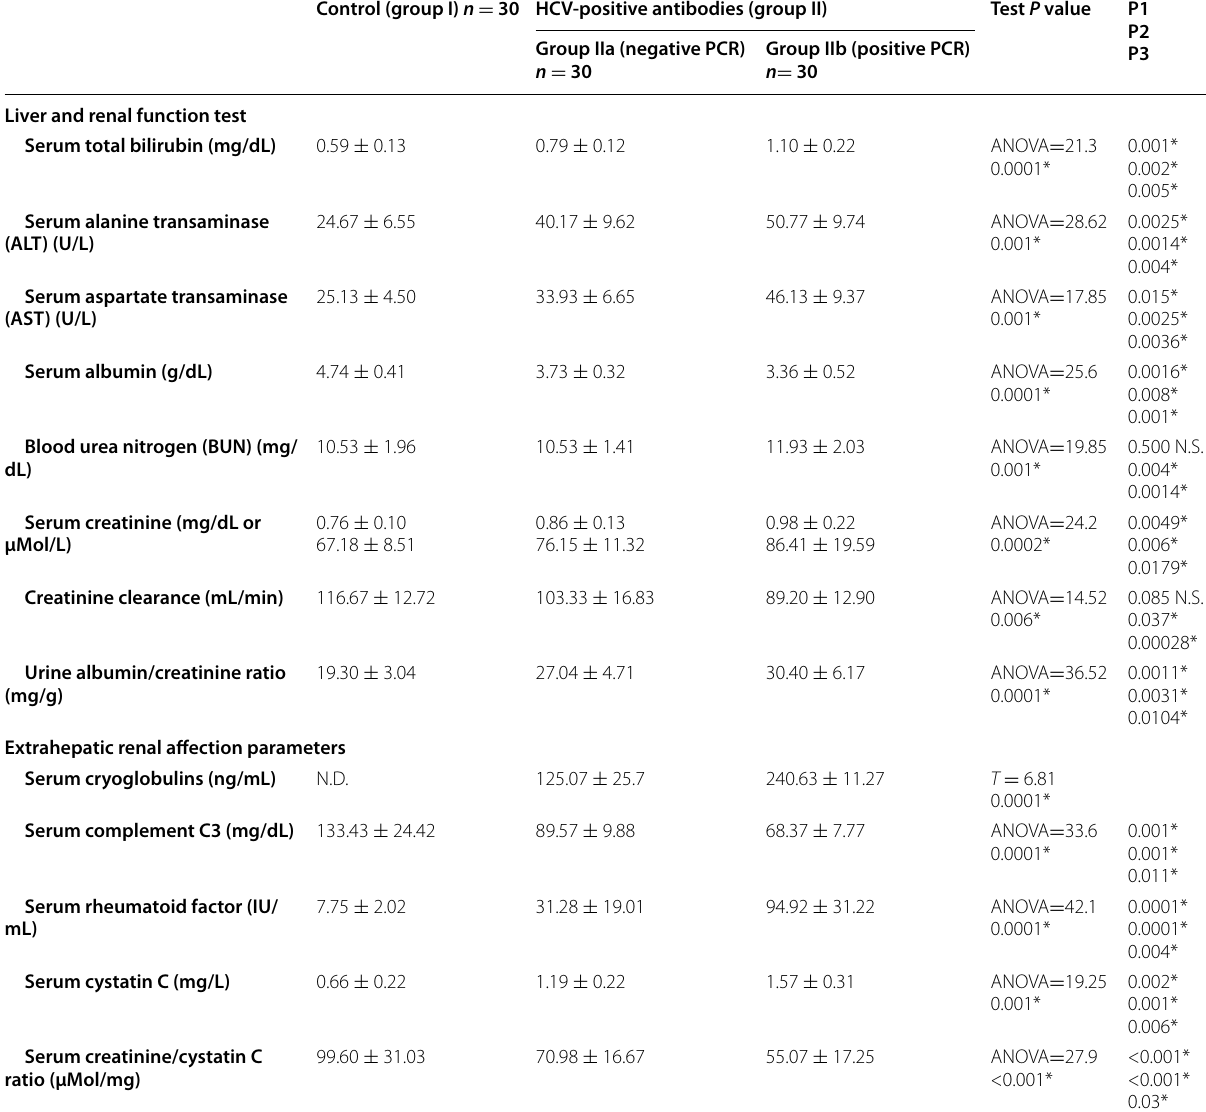
P1: comparison between the control group and group IIa. P2: comparison between the control group and group IIb. P3: comparison between groups IIa and IIb * P was significant if <